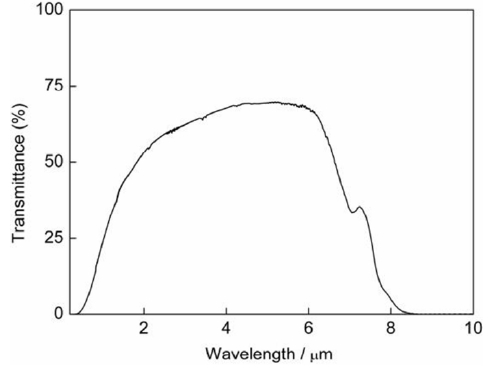
Fig. 15 Transmittance of La 2 Zr 2 O 7 transparent ceramic sintered at 1400 ℃ for 45 min (1 mm thick). Reproduced with permission from Ref. [44], © Trans Tech Publications, Switzerland